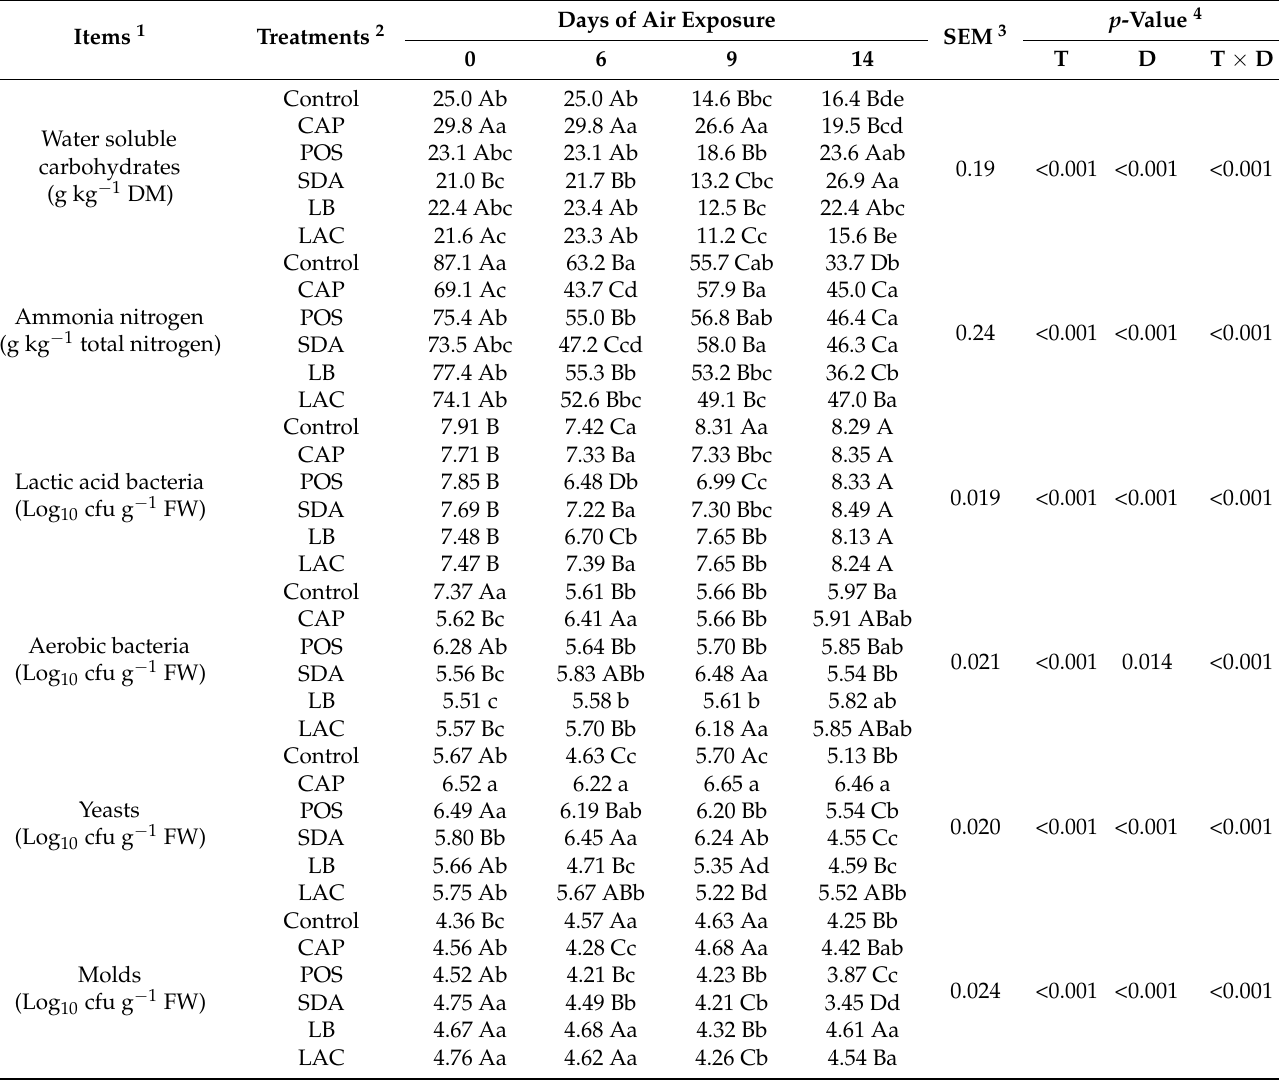
Table 5. Changes in microbial and chemical compositions of total mixed ration silage after exposure to